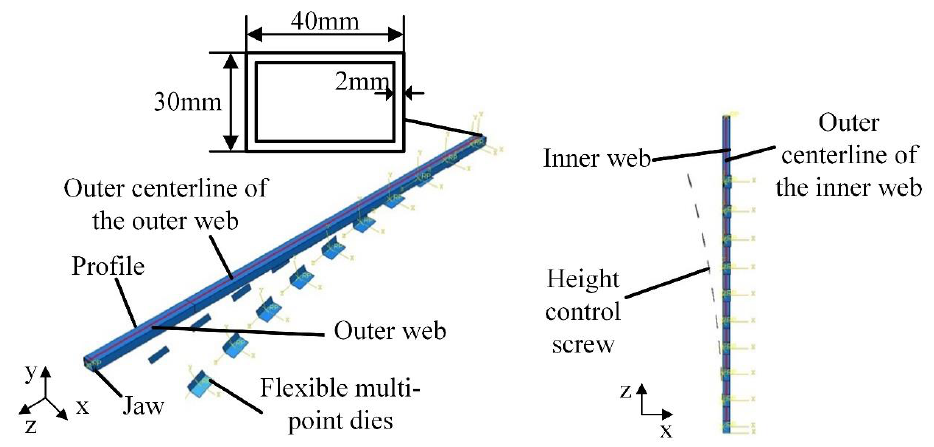
Figure 1. Finite element assembly model.